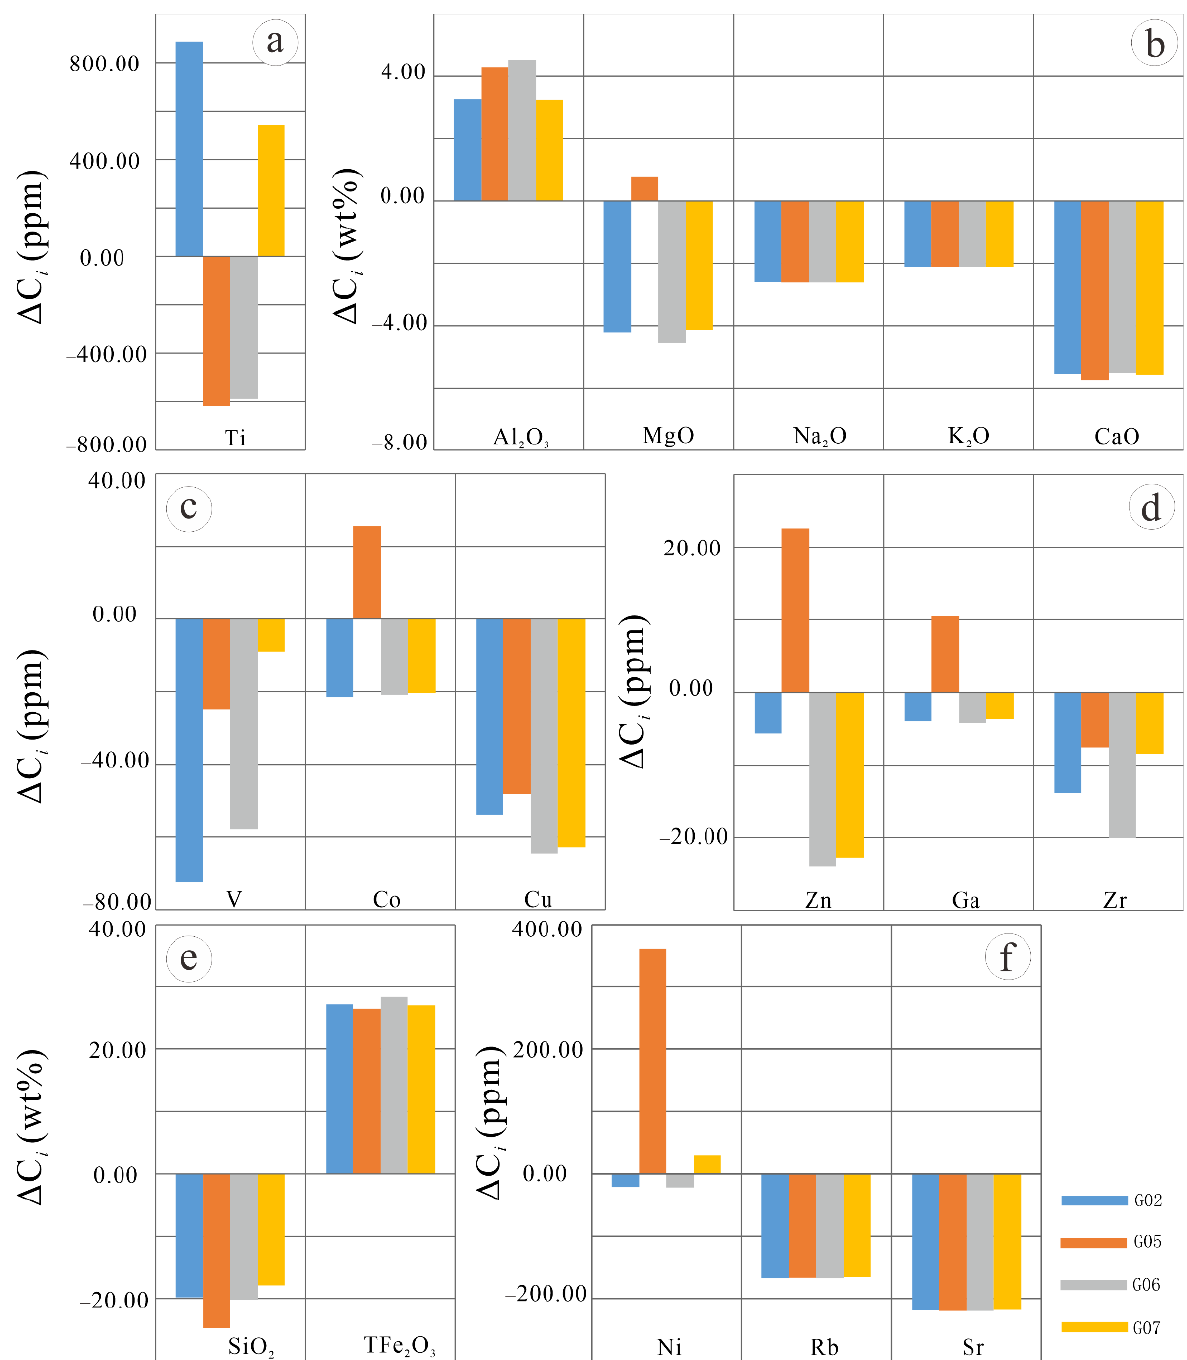
Figure 8. The results image of the mass balance calculation. ( a ) The gains and losses of Ti in altered rocks; ( b ) The gains and losses of major components in altered rocks; ( c ) The gains and losses of V, Co, and Cu in altered rocks; ( d ) The gains and losses of Zn, Ga, and Zr in altered rocks; ( e ) The gains and losses of SiO 2 and TFe 2 O 3 in altered rocks; ( f ) The gains and losses of Ni, Rb, and Sr in altered rocks.